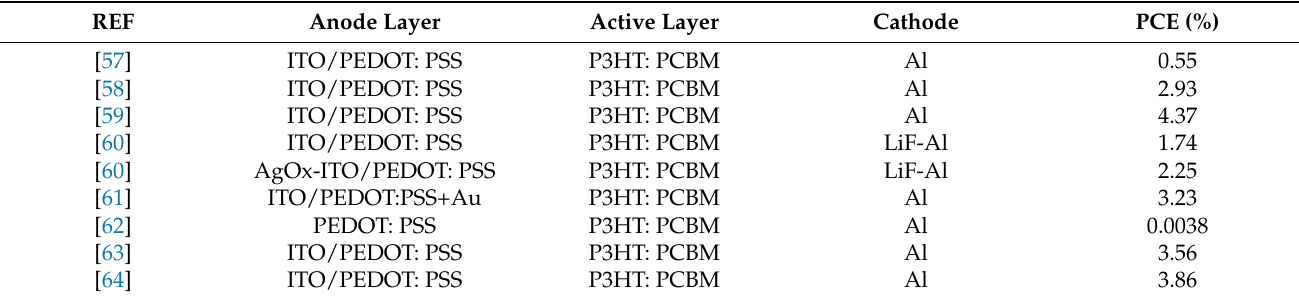
Table 5. Summary of ITO-based electrodes with the best PCEs for OPV cells.